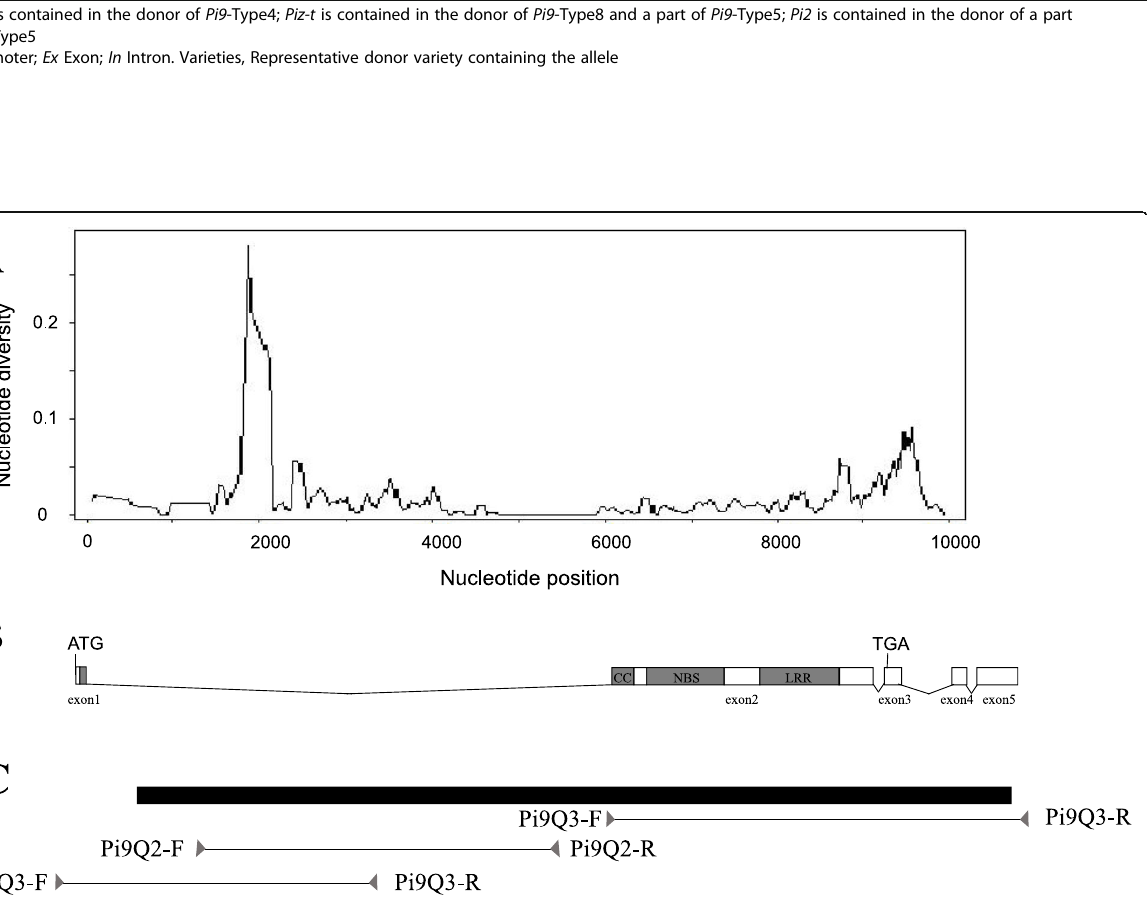
Fig. 2 SNP rich region in the Pi9 alleles. a . Sliding-window analysis of nucleotide diversity ( π ) about new Pi9 alleles are shown above; b . The gene structure is described at the unit scale of nucleotide location, and the domains (CC, NBS and LRR) are illustrated as gray frames; c . Schematic diagram of the location of the primers used to amplify the Pi9 alleles. The unit scale indicates the location of